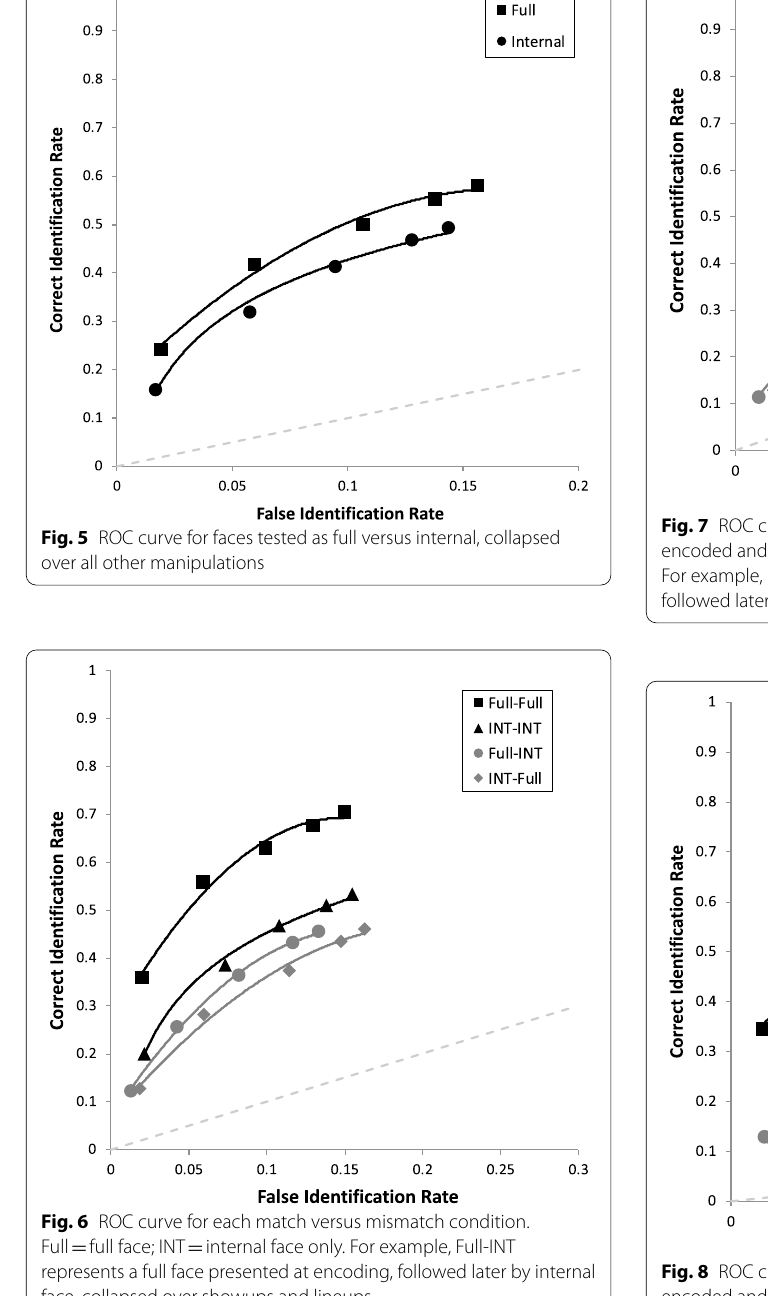
full face; INT internal face only. = =